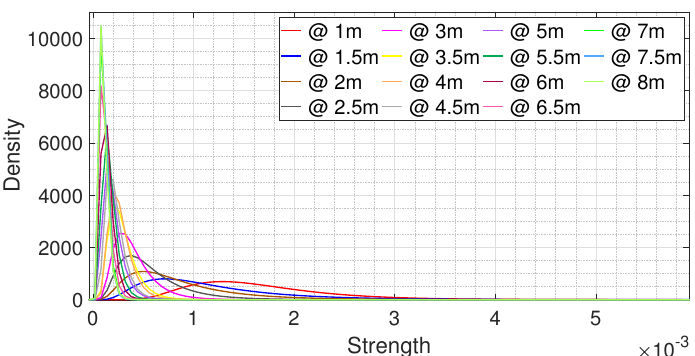
Figure 9. The fitting results for the signals reflected from the person at different distances.